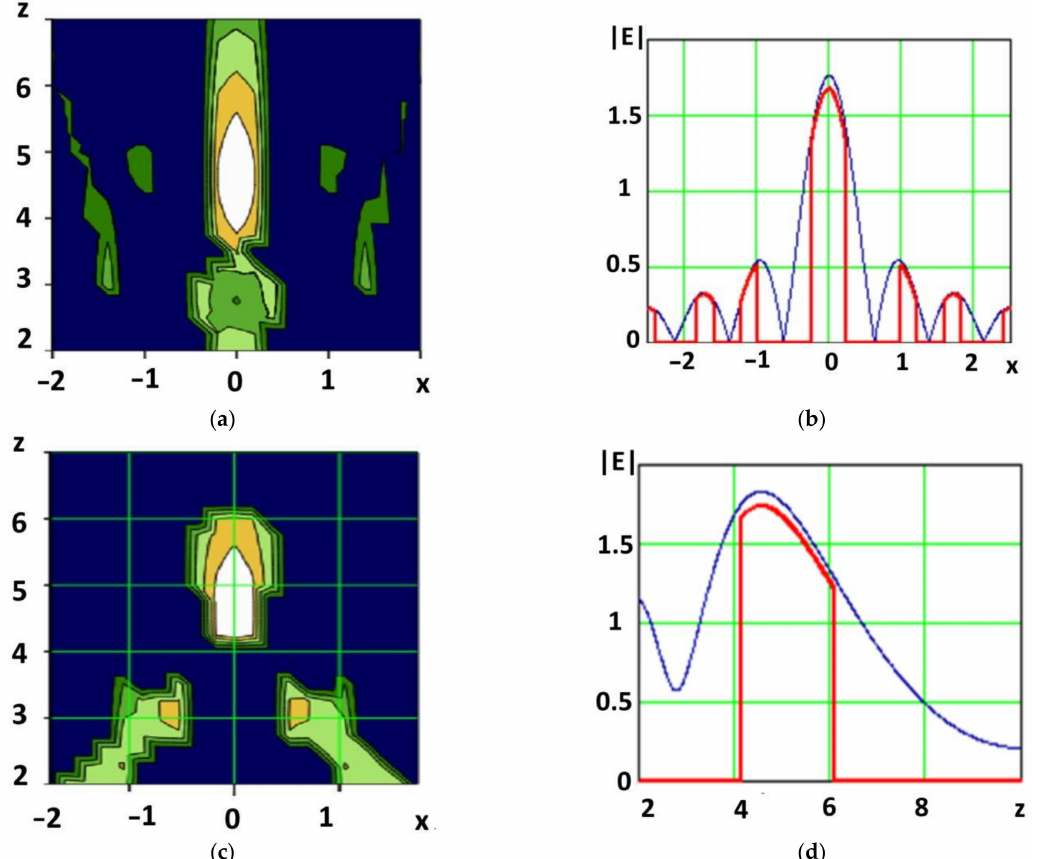
Figure 14. Results of processing according to the algorithm (8): ( a , c ) spatial distributions; ( b , d ) sections at the focal point in the directions across and along the aperture, blue line shows sum type of distribution, red line shows result of sum-difference processing.